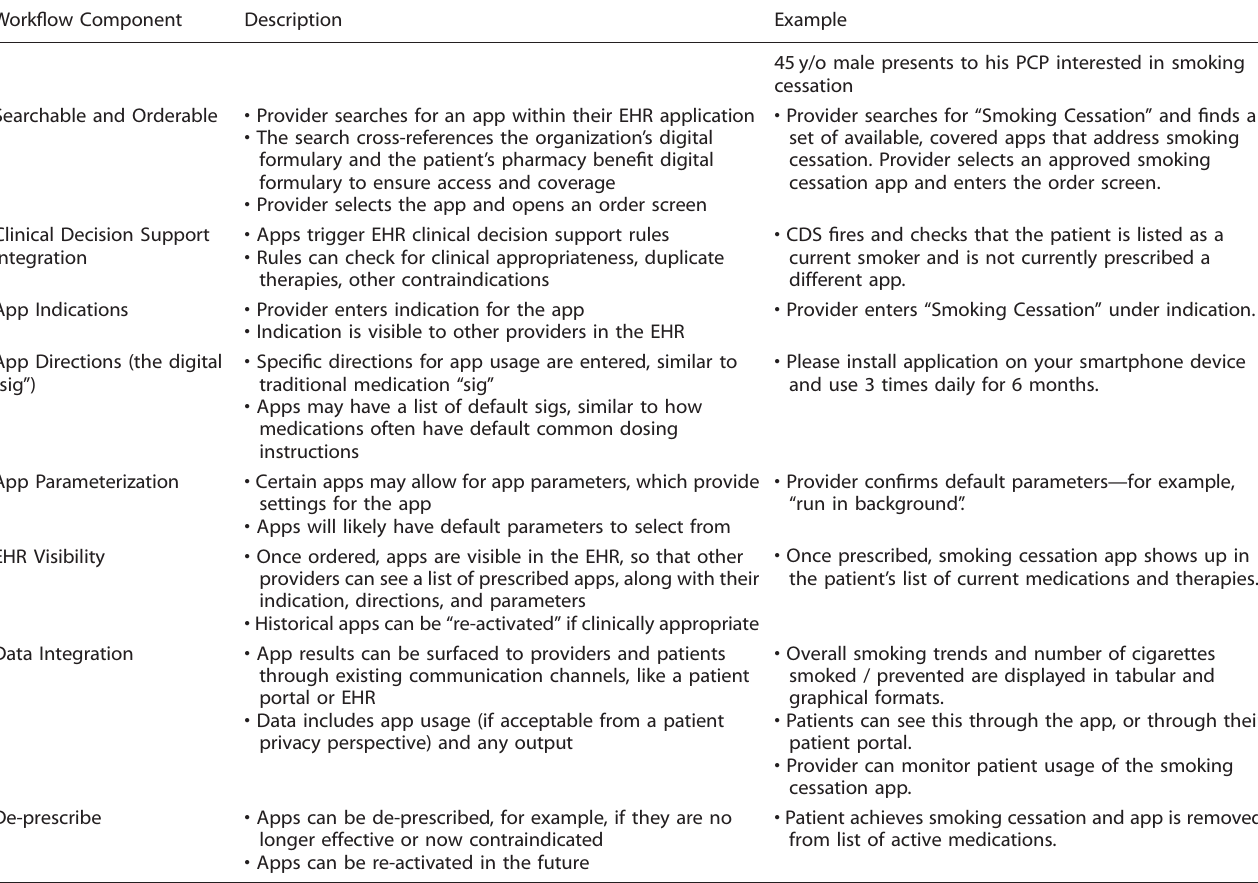
Table 1. Prescribing apps as a component of clinical work fl ow. A smoking cessation app is used as an example. Work fl ow Component Description Example